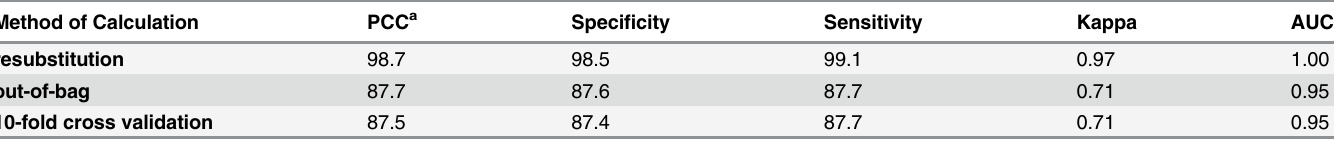
Table 2. Accuracy metrics for the Florida panther habitat